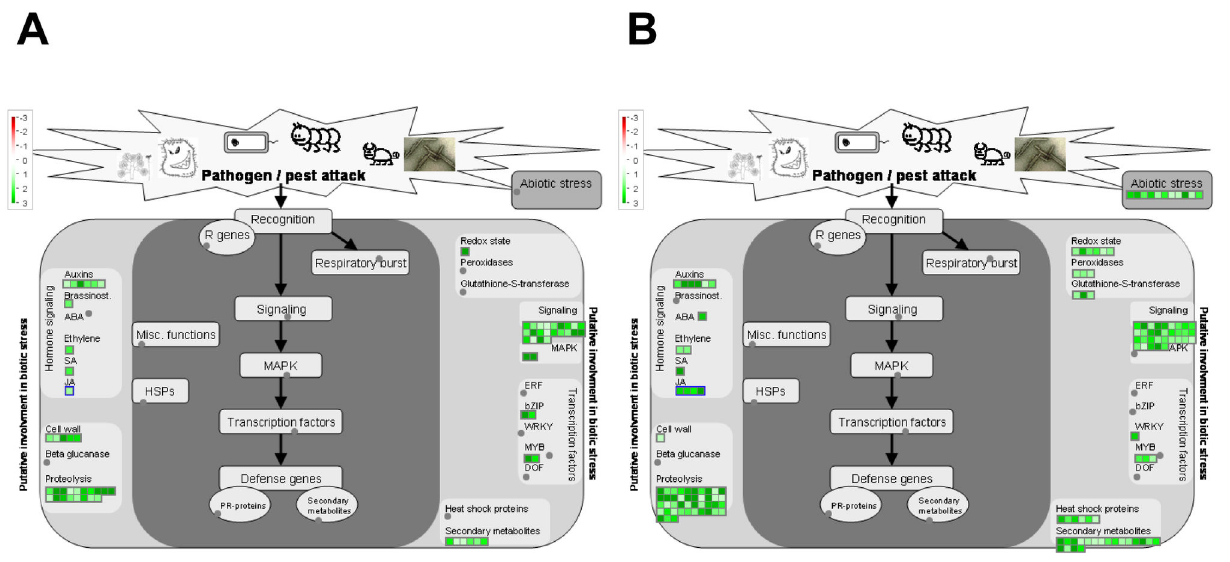
Figure 6. MapMan illustration depicting biotic stress-related transcripts with a relative higher expression when mock- inoculated samples are compared. Transcriptomic data from mock-inoculated leaves of MG-20 and Gifu B-129 were compared to each other. Genes that were shown to be differentially expressed in MG-20 (A) and Gifu B-129 (B) were mapped using the MapMan software. Picture shows only those genes related to biotic stress. Log fold change ratios are indicated as a gradient of